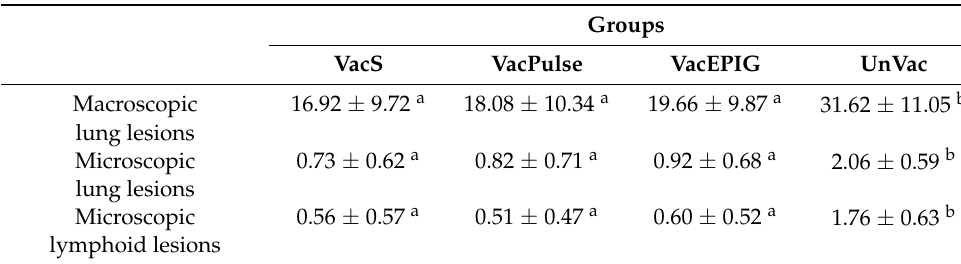
Table 3. Macroscopic and microscopic pathology (mean ± standard deviation) of vaccinated and unvaccinated groups.